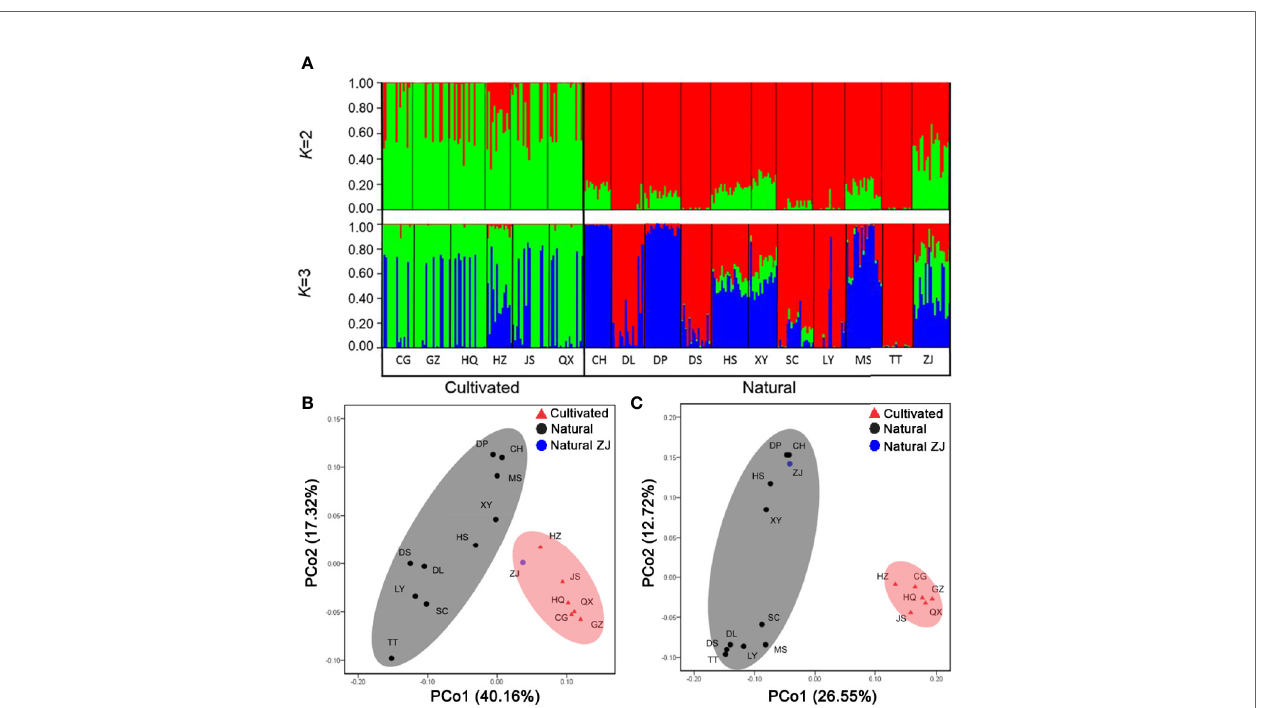
FIGURE 3 | Genetic and epigenetic populations structure of C. yanhusuo using STRUCTURE and PCoA analysis. (A) Individual assignment to each cluster for K=2 to 3 based on genetic dat. Each individual is represented by a thin vertical line. Principal coordinates analysis (PCoA) among C. yanhusuo based on the AFLP pro fi le (B) and MSAP pro fi le (C) .